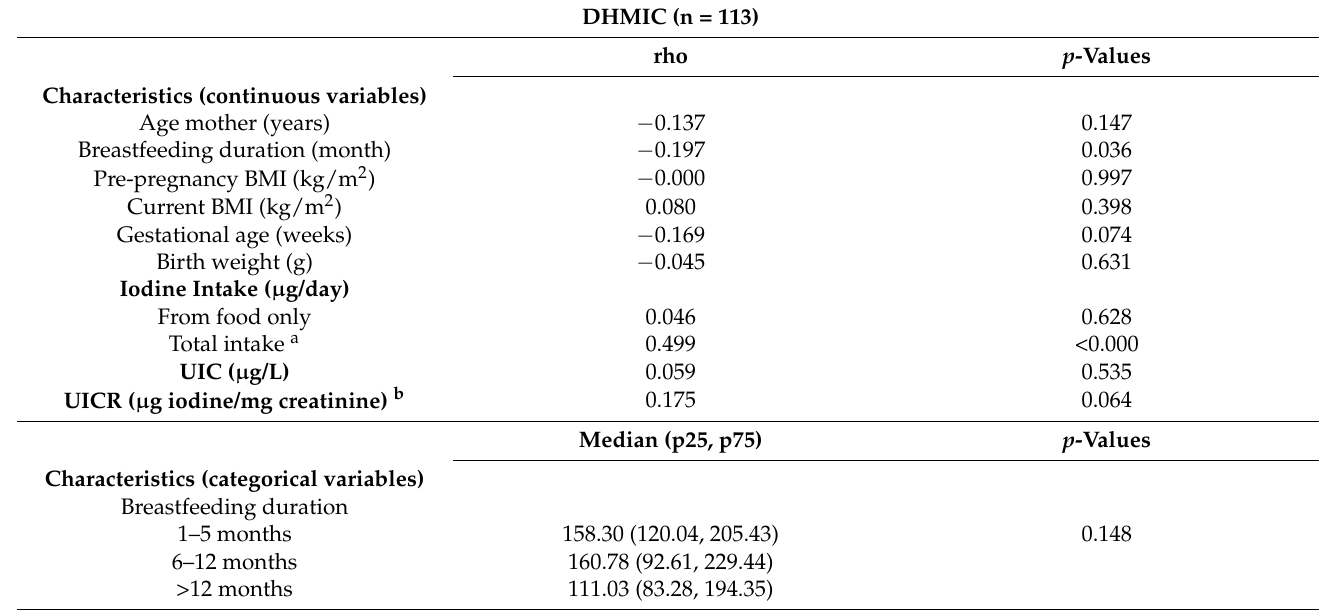
Table 5. Associations between donor human milk iodine concentration (DHMIC) and